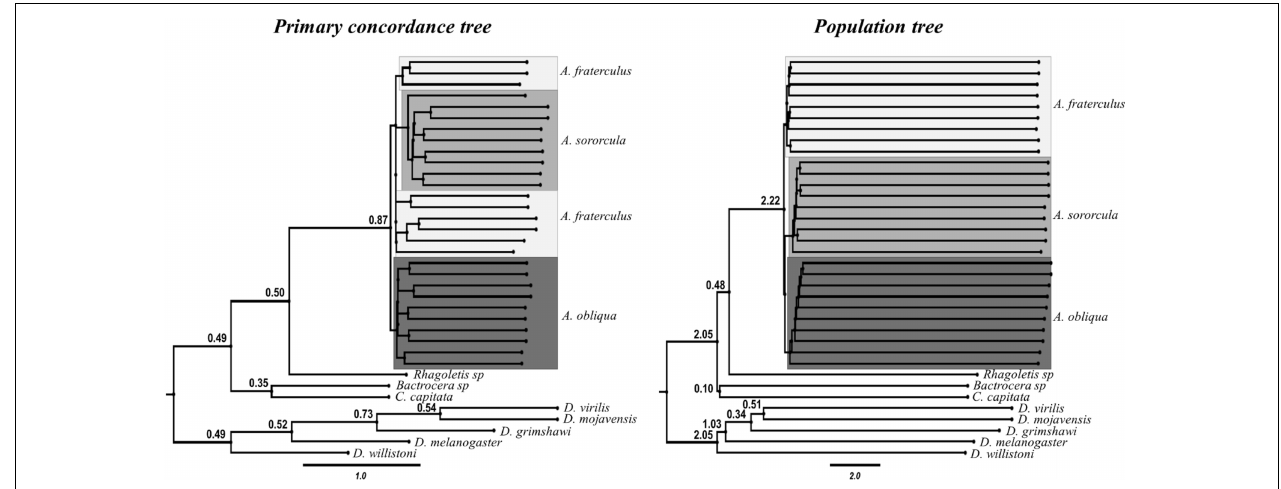
FIGURE 3 | Primary concordance tree (PCT) and Population Tree (PT), obtained from the Bayesian concordance analysis in BUCKy. Posterior mean concordance factors (CFs) are displayed above branches. Branches with concordance factors below 0.1 are not shown except in major nodes. Topologies differed among trees, only the PT shows monophyly for the three species. Samples for each Anastrepha species are differentially highlighted. The PCF tree shows poorly supported relationships implying some level of